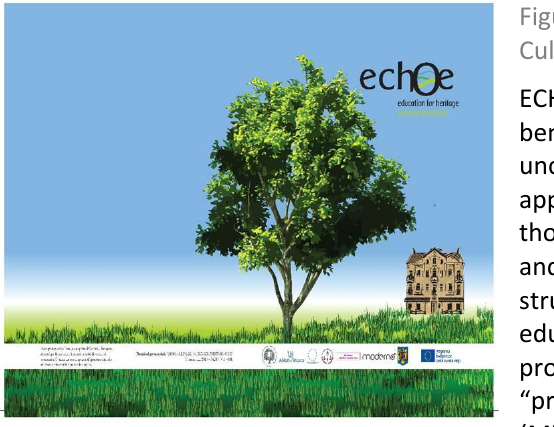
(Ministry of Culture, Romania, 2013, p.